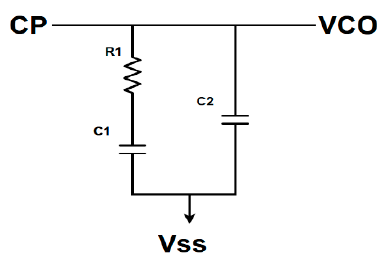
Figure 2. Loop Filter’s schematic view.